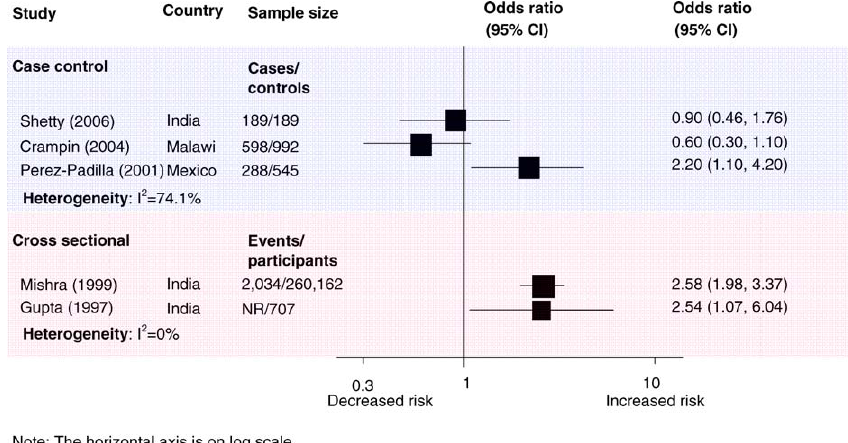
Figure 8. Risk of Clinical TB Disease for Indoor Air Pollution Exposure Compared with Nonexposure